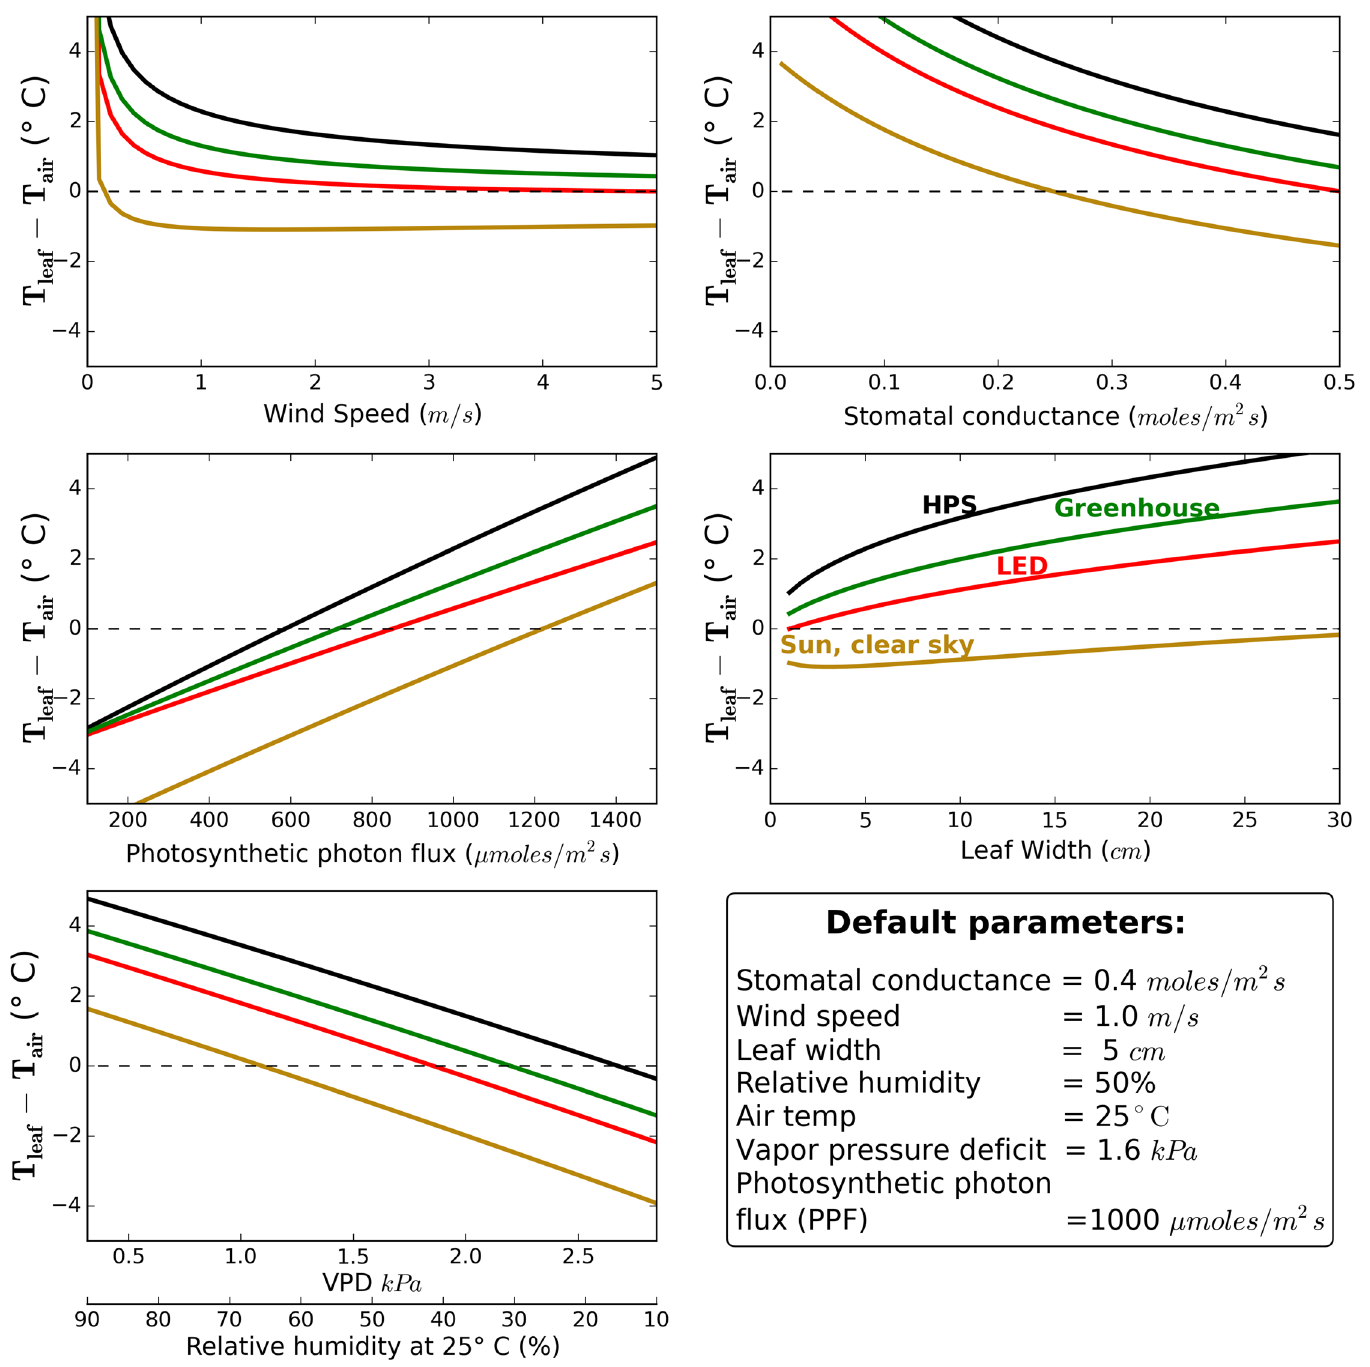
Fig 4. Calculated effects of environmental conditions on the difference between leaf temperature and air temperature under four radiation scenarios.